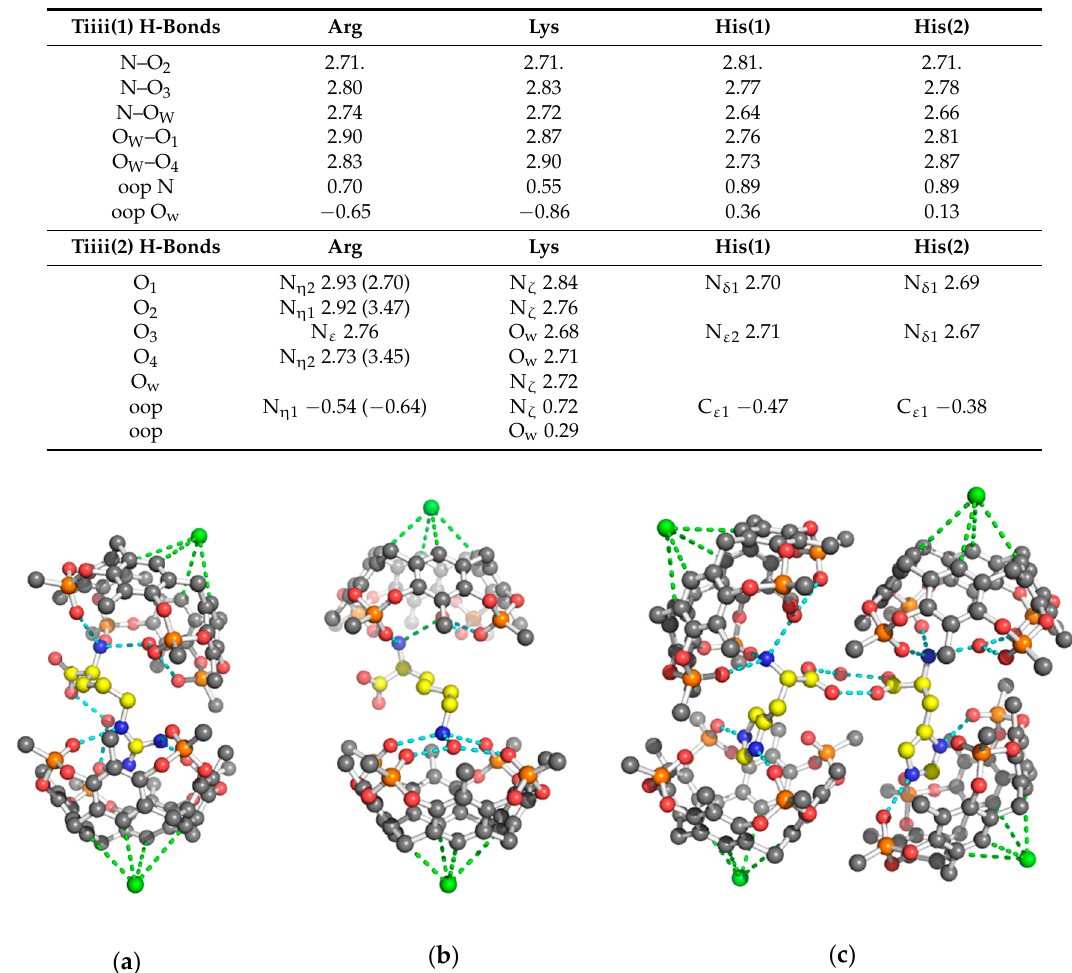
CH 3 ] • His · 2HCl complex. Values in brackets correspond to the II conformation of Arg.